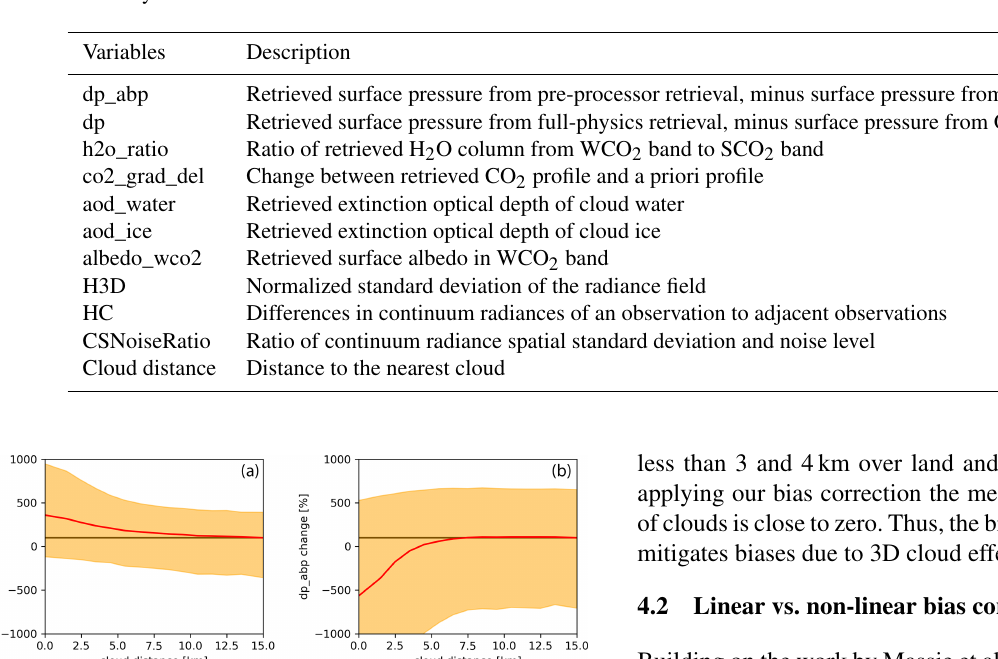
Table 2. Summary of OCO-2 state vector variables and 3D cloud variables.